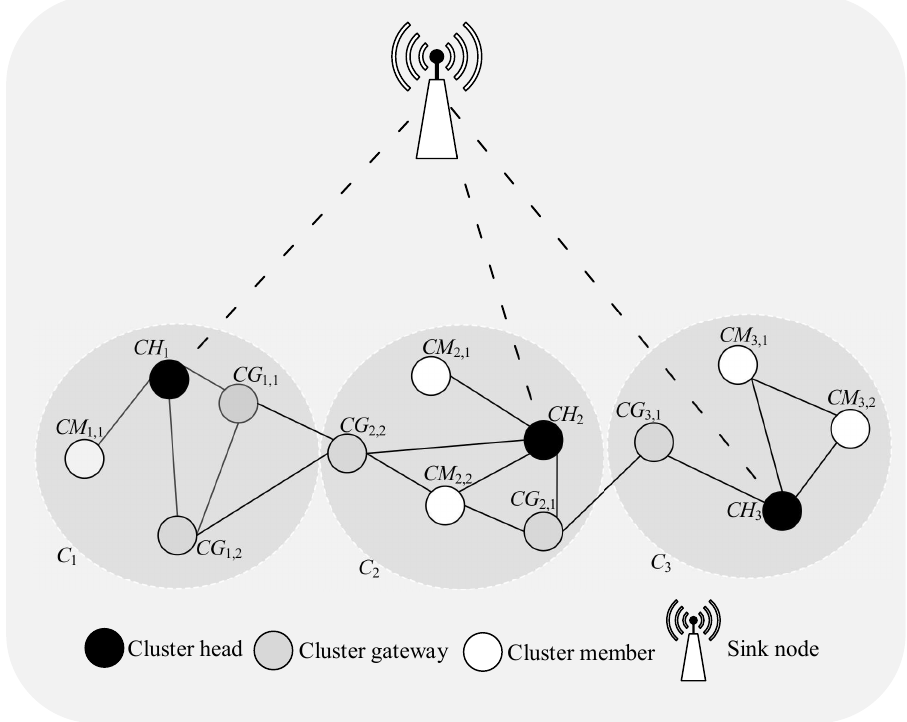
Figure 1. Node clustering architecture for underwater sensor networks